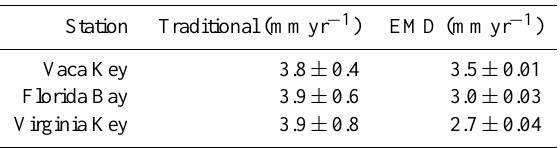
Table 3. Linear models of mean sea level rise. EMD is the linear re- gression of the MSL EMD residual with the Florida Current trans- port estimate